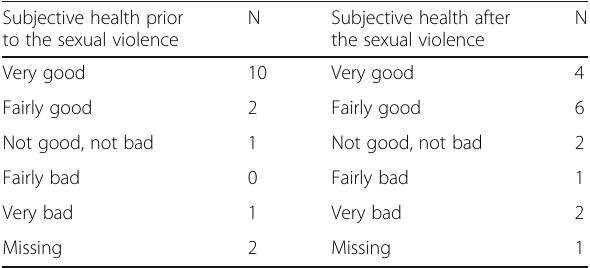
Table 2 Subjective health rate prior to and after the sexual victimisation ( N = 16) Subjective health prior N Subjective health after N to the sexual violence the sexual violence Very good 10 Very good 4 Fairly good 2 Fairly good 6 Not good, not bad 1 Not good, not bad 2 Fairly bad 0 Fairly bad Very bad 1 Very bad 2 Missing 2 Missing